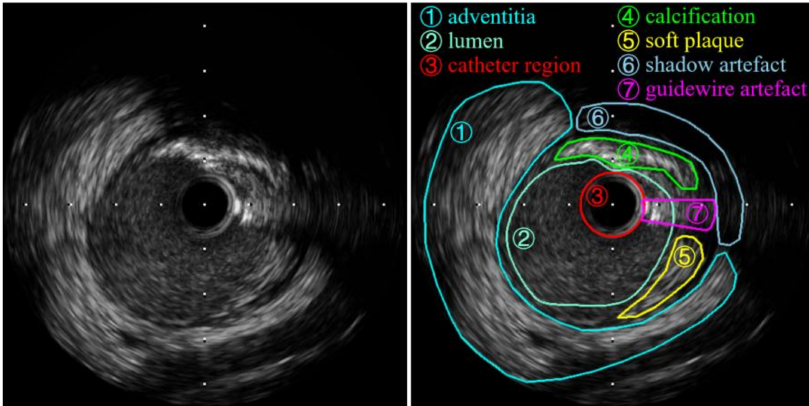
Figure 1. The example intravascular ultrasound (IVUS) image ( left ), and the same image with intravascular structures and artifacts labeled ( right